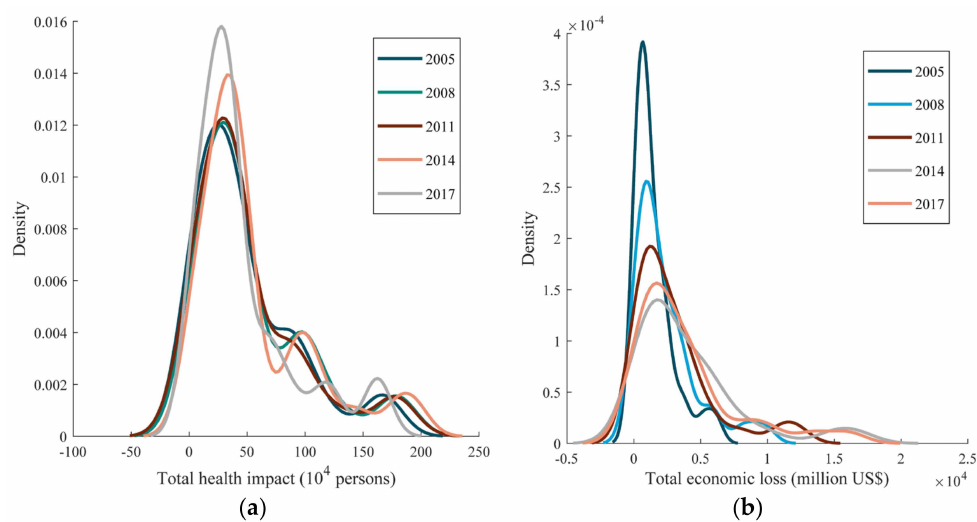
Figure 8. Kernel density analysis of the health impact and economic loss by PM 2.5 exposure. ( a ) Kernel density analysis of the health impact. ( b ) Kernel density analysis of the economic